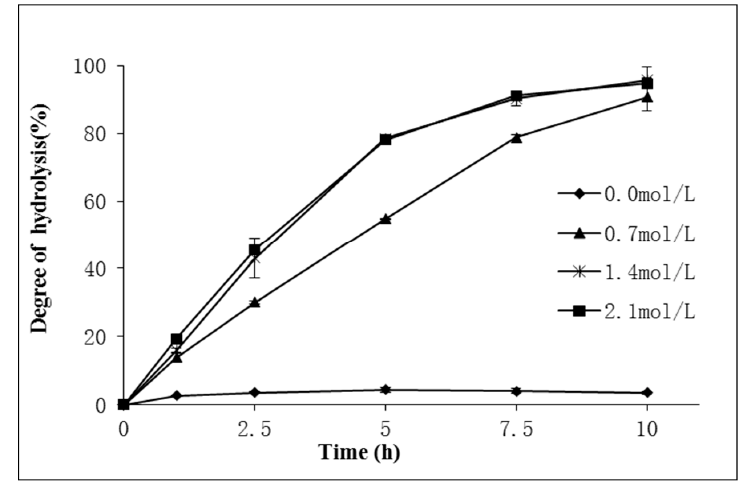
Figure 8. The effect of the sulphuric acid dosage on the hydrolysis of Schizochytrium sp. oil. (Reaction temperature = 95 °C, Water to oil ratio = 3:1 (w:w), 1% Sodiumdodecyl-sulfate based on oil weight, 750 rpm).